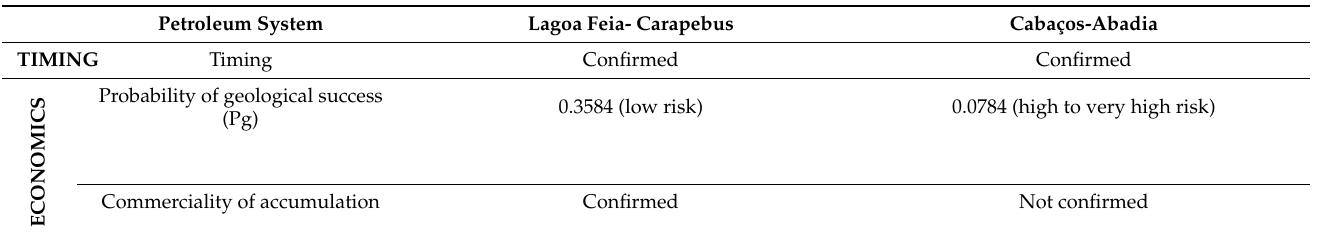
Table 2. Analysis of the efficiency of the static and dynamic elements, timing and economic aspects of the proven petroleum